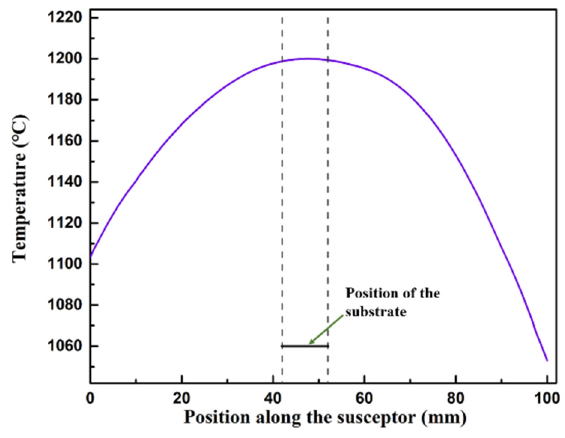
Figure 1. Temperature distribution along the susceptor.